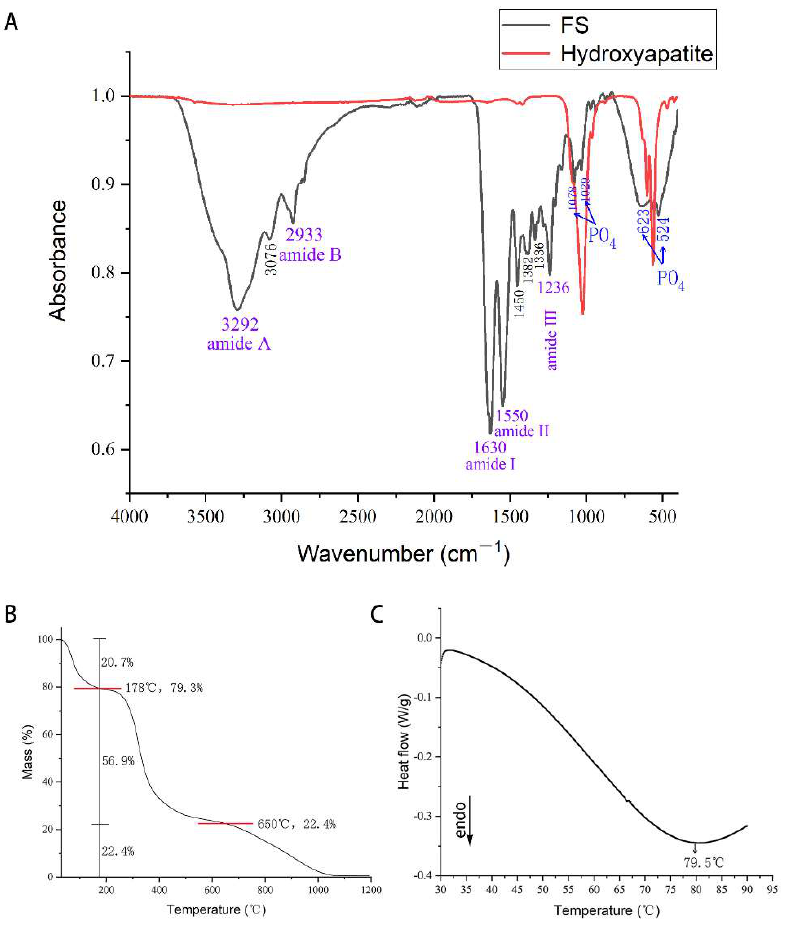
Figure 3. FTIR ( A ), thermogravimetric analysis ( B ), and DSC ( C